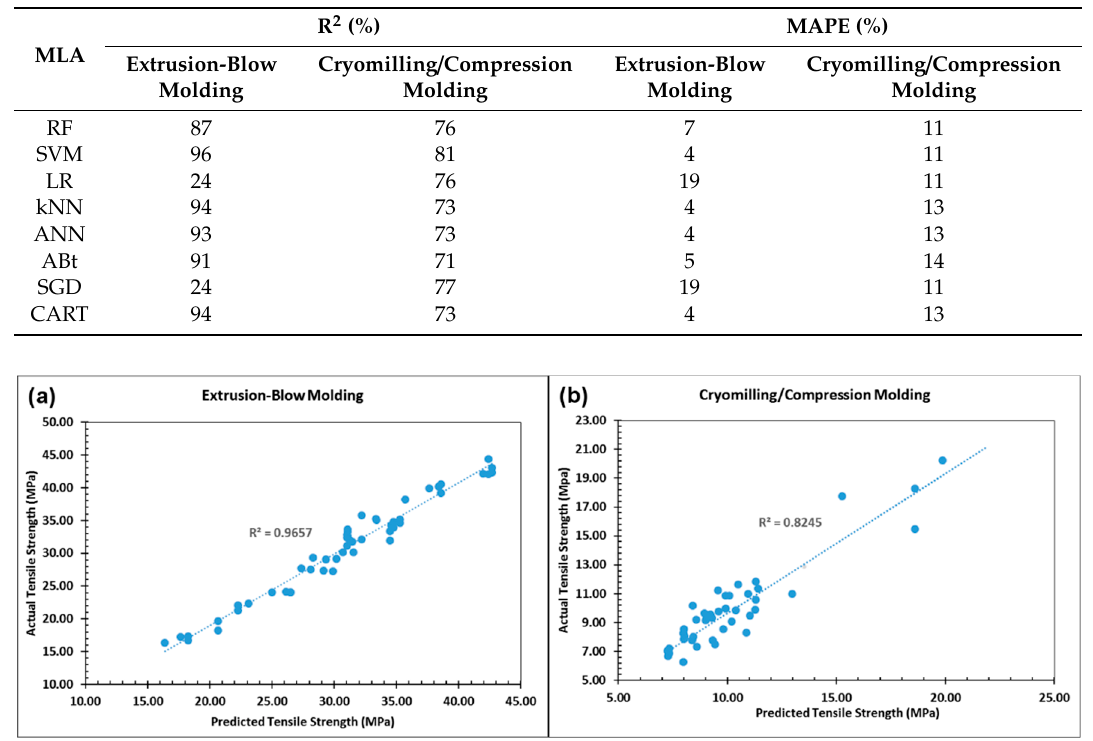
Table 4. MLA prediction evaluation for the film production processes.